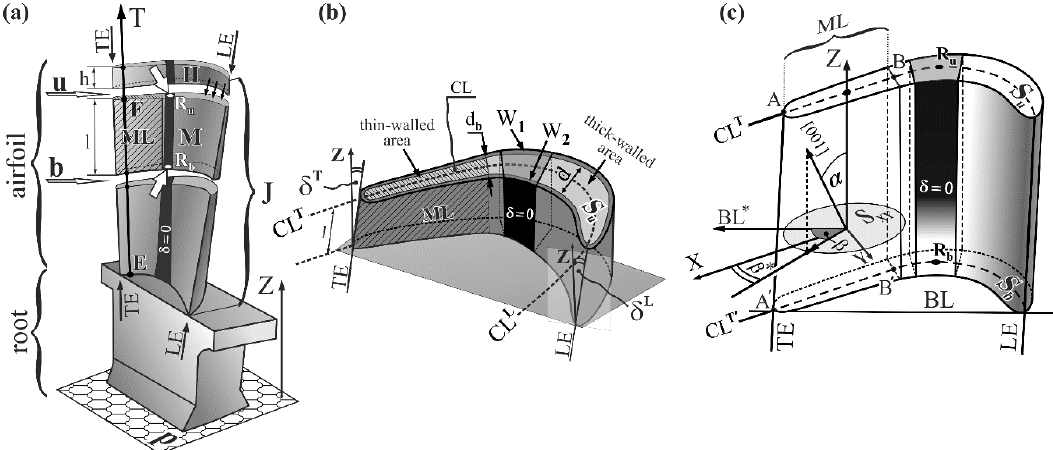
Figure 1. ( a ) Illustration of turbine blade with cutting scheme (LE — leading edge, TE — trailing edge, T axis is parallel to TE); ( b ) shape of sample M with scheme of mould walls arrangement (CL — camber line, S u — micro-section surface, W 1 , W 2 — mould walls, d — distance between mould walls, δ T — angle line, S u —micro-section surface, W 1 , W 2 —mould walls, d—distance between mould walls, δ T —angle between axis Z and TE, δ L — angle between axis Z and LE); ( c ) geometric description of α, β and β* between axis Z and TE, δ L —angle between axis Z and LE); ( c ) geometric description of α , β and β * angles; plane S XY is parallel to plane p in Figure 1a and BL* is parallel to BL. angles; plane S XY is parallel to plane p in Figure 1a and BL* is parallel to